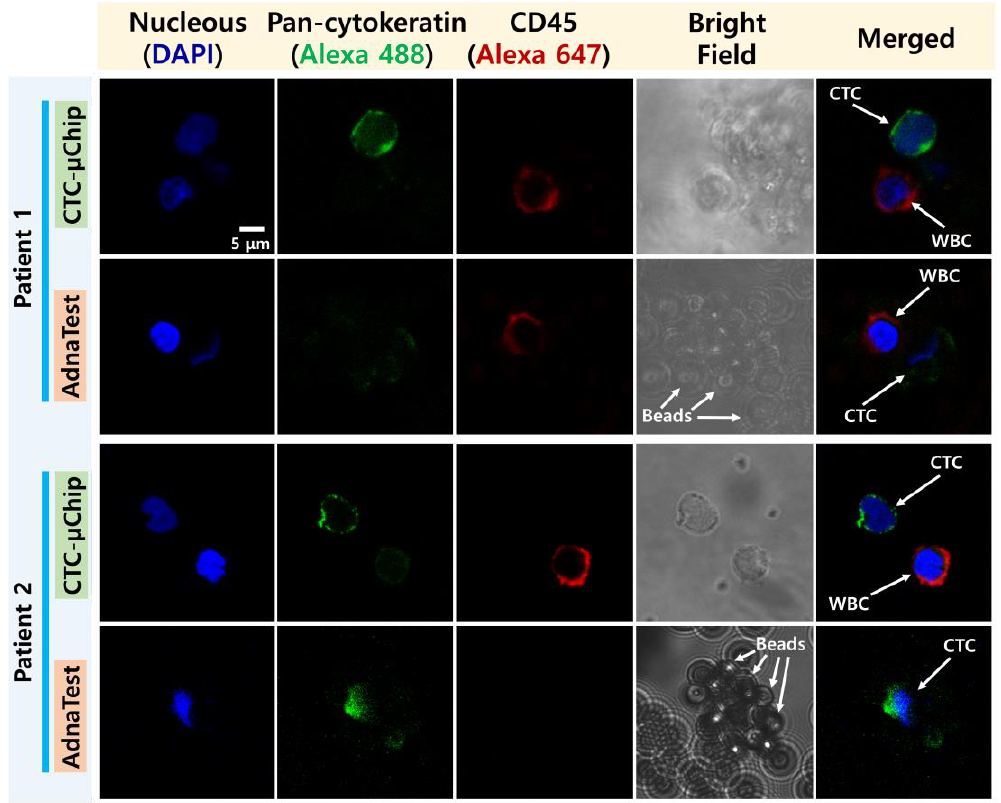
Figure 3. Immunofluorescence confocal microscopy images of prostate CTCs and white blood cells (WBCs) isolated by the CTC-µChip and AdnaTest.